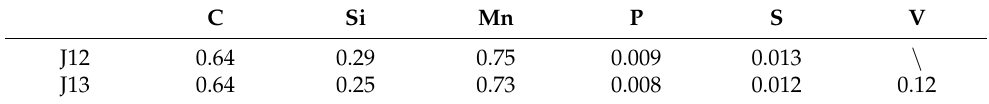
Table 1. The chemical compositions (mass percentage, wt.%).